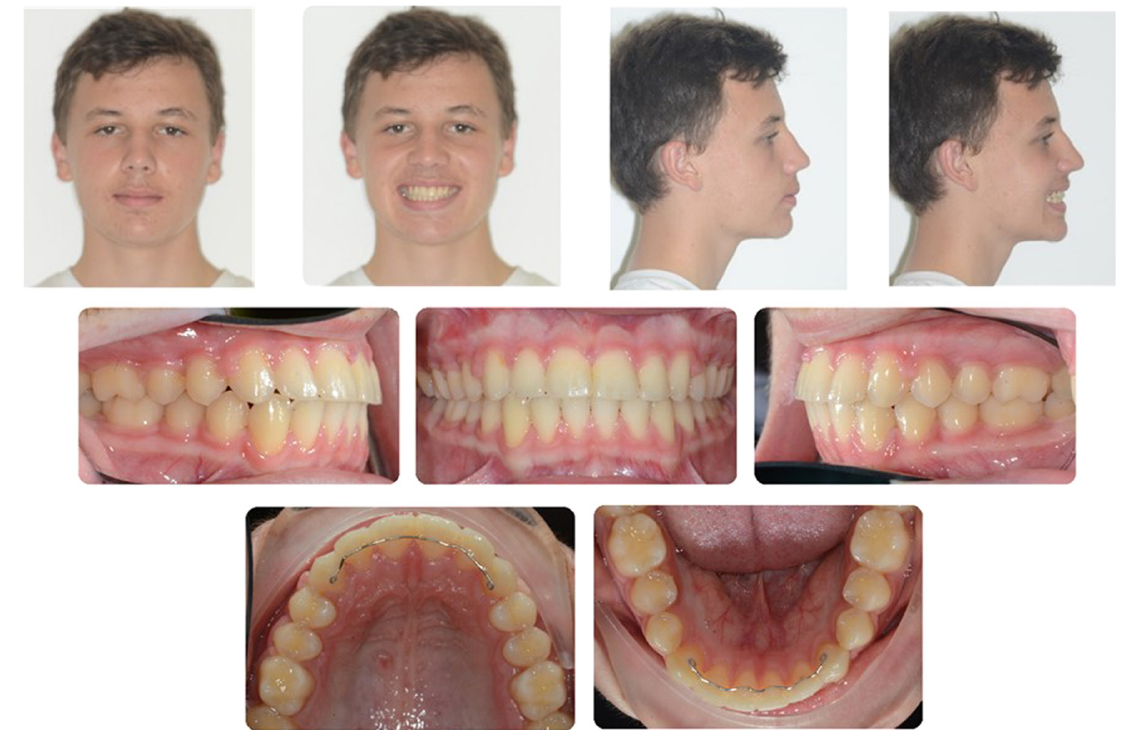
Figure 8. Post-treatment